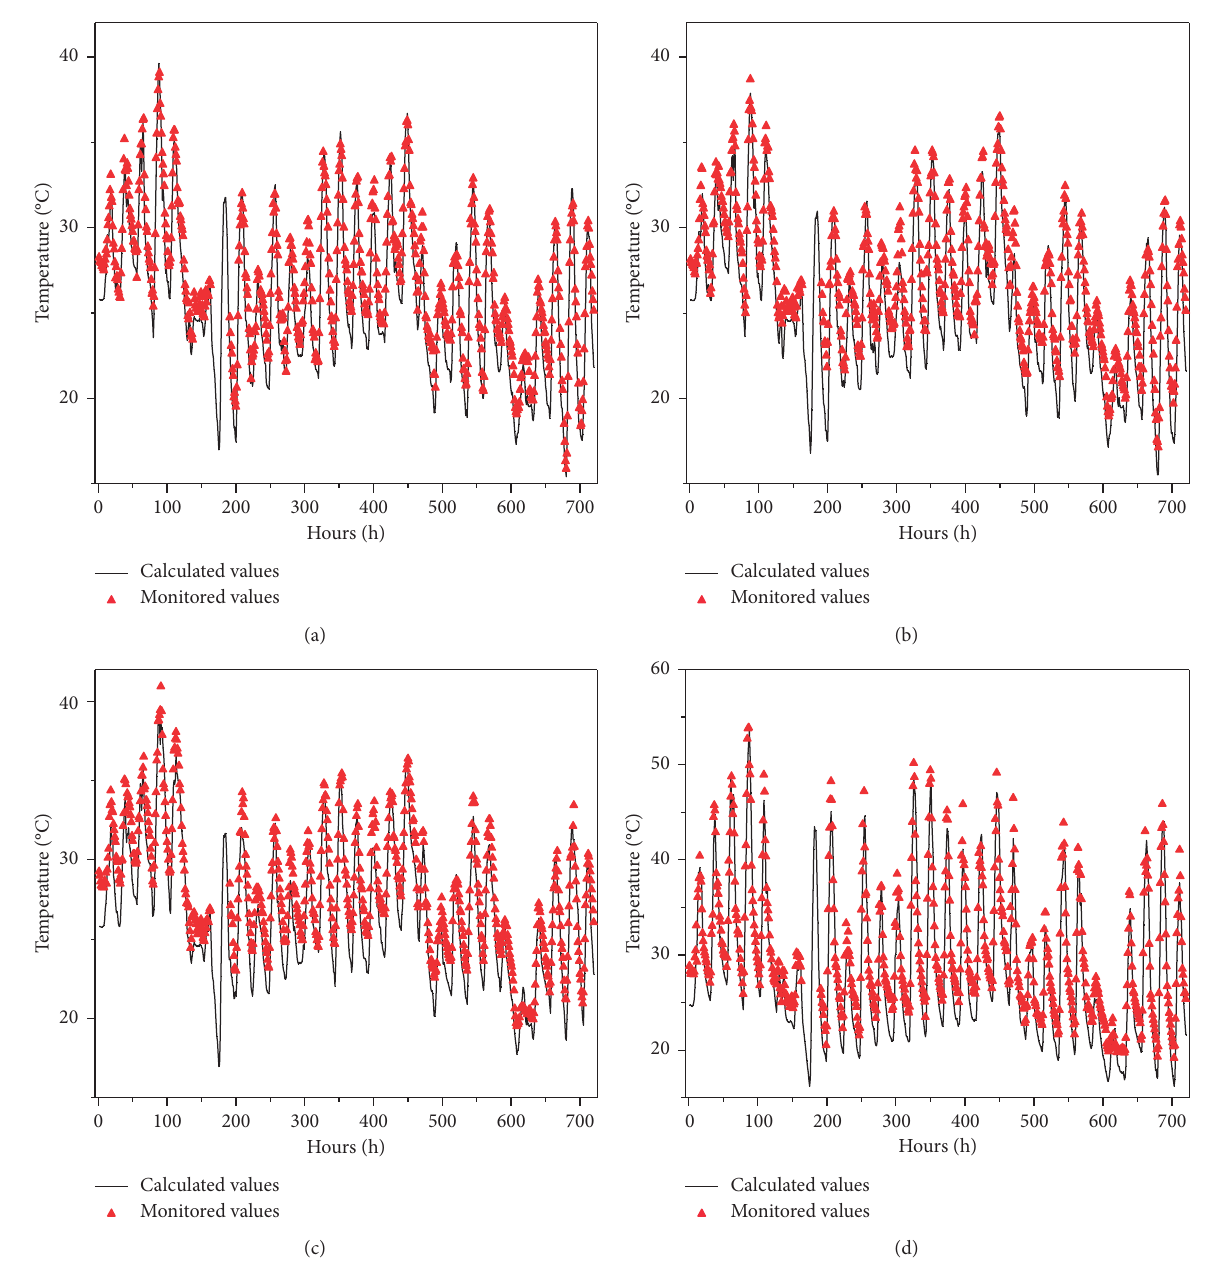
Figure 7: Comparisons of variation of temperature between calculated and monitored values of typical measuring points in September. (a) Flange measuring point T1. (b) Web measuring point T3. (c) Bottom measuring point T10. (d) Bridge deck measuring point